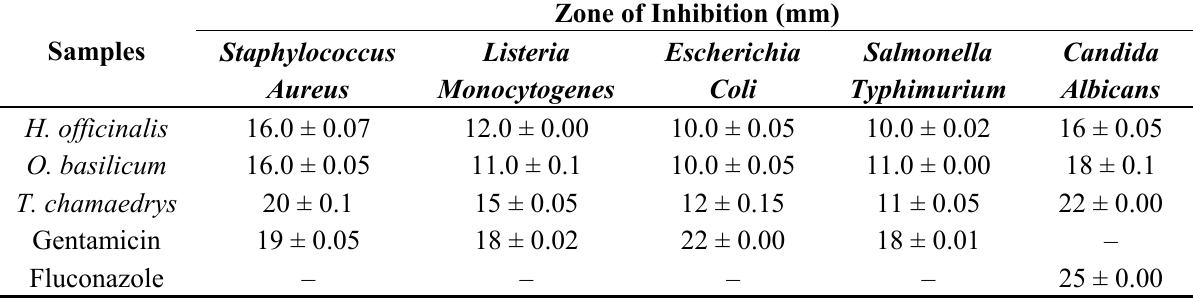
Table 4. Results of the antimicrobial activity of H. officinalis , O. basilicum and T. chamaedrys extracts in agar diffusion